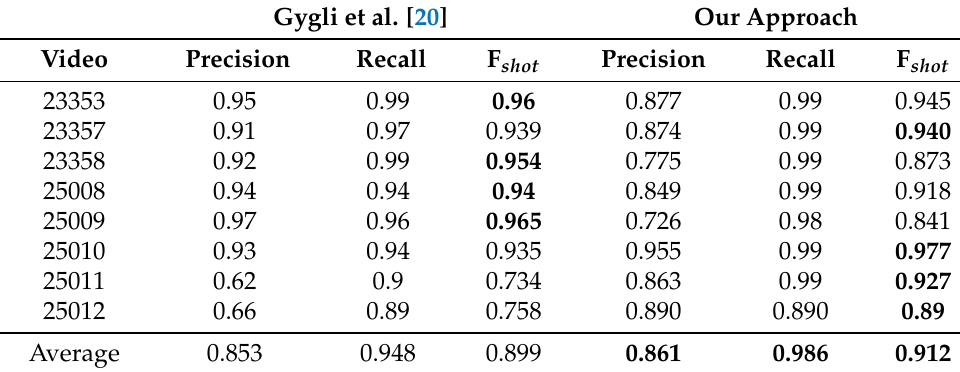
Table 1. Performance comparison for shot detection using boundary-level metrics.